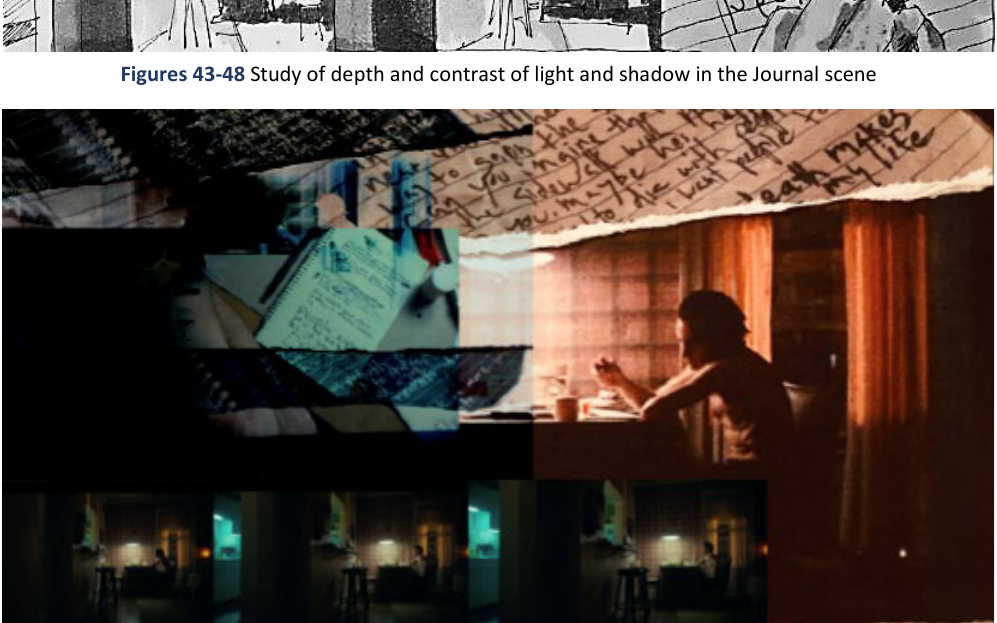
Figure 49 Journal Collage 1: The first Joker collage is a digital composite of images which emphasise the journal as a central component and introduces layers representing conscious and unconscious thought, gradually becoming expressed within the